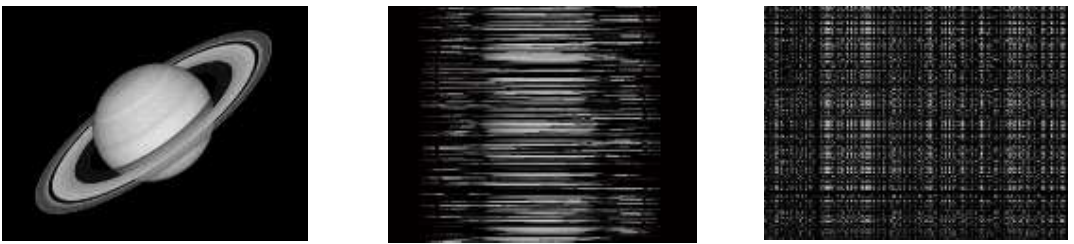
Fig. 3 Three images have very different spatial configurations but identical Shannon entropy (Gao and Li